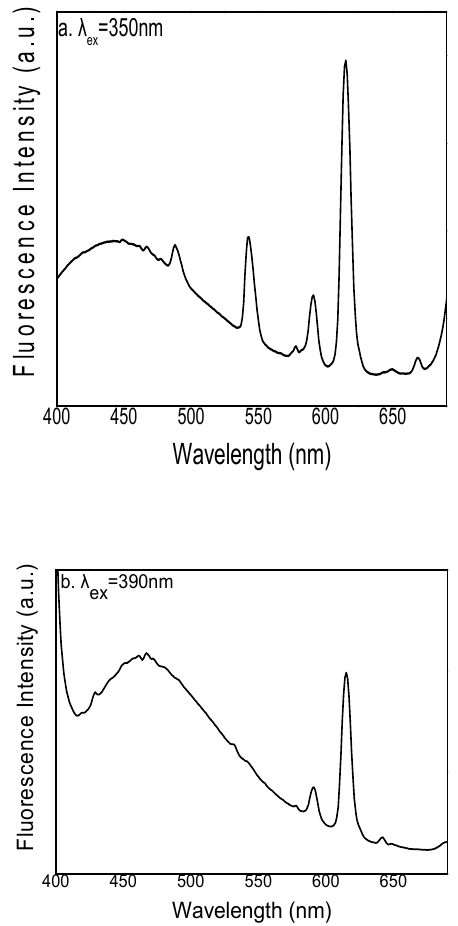
Figure 5. Photoluminescence (PL) excitation spectra of modified rare-earth complexes with wavelengths ( a ) 350 nm, ( b ) 390 nm.